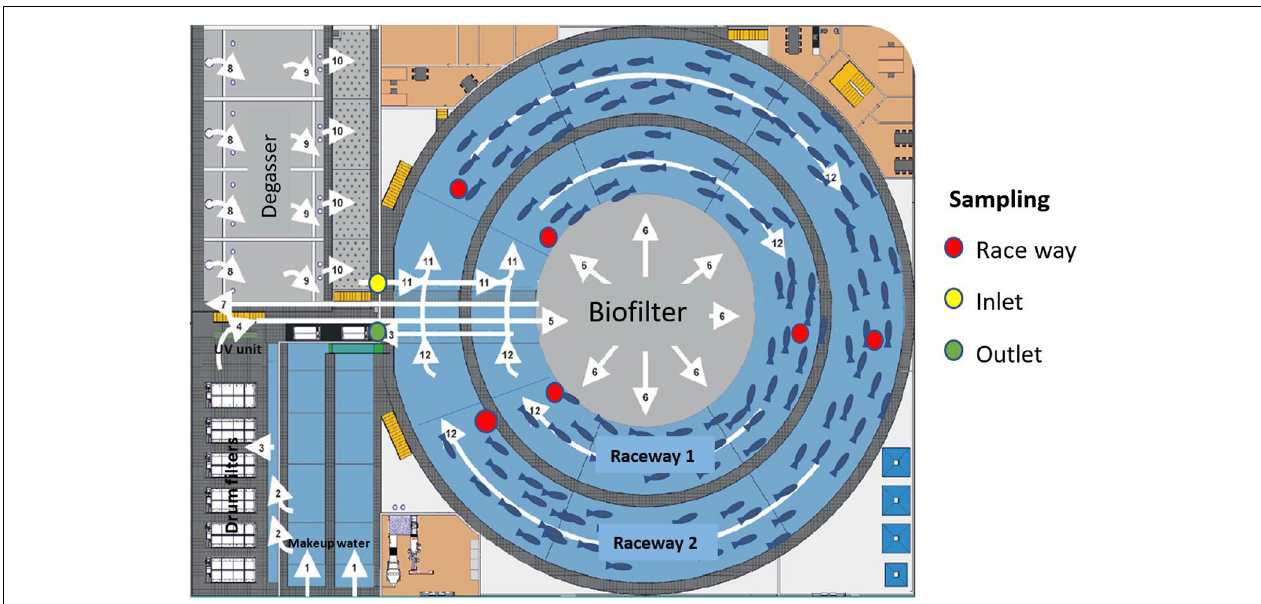
FIGURE 1 | Illustration of a RAS module at Fredrikstad Seafood – water flow through the water treatment loop (white arrows show the direction of flow). The system is comprised of circular raceways for holding fish with a volume of 7,300 m 3 , six drum filters of different mesh sizes (ranging from 20 to 50 µ m), a biofilter with five chambers, and a degassing unit. New water (1–2) enters the systems and goes (3) through six drum filters of different mesh sizes (20–50 µ m). The permeate from the drum filters is split (10%) into a UV contact chamber (4) and (90%) in a 5-chamber biofilter (5–6). The water is re-mixed (7) at the entrance to a degassing unit (8–10). After the degasser, the water then enters a 7,300 m 3 fish tank (11) and is split between an inner and outer raceway ring. The water exits in the fish tanks (12) and re-enters the water treatment loop via the drum filters (13). RAS, recirculating aquaculture